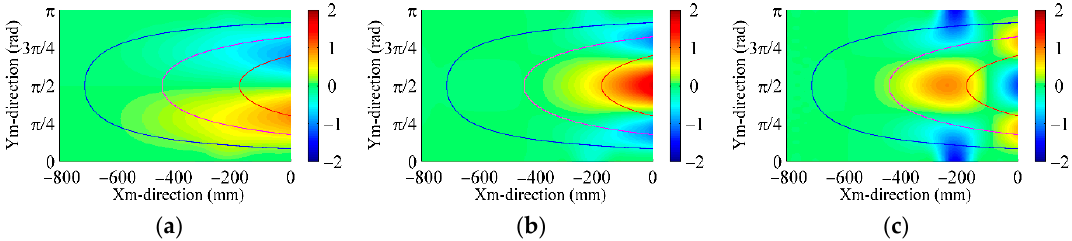
Figure 7. First three modal shapes of the semi ‐ conical shell workpiece with three chosen contour tool paths: ( a ) first modal shape; ( b ) second modal shape; ( c ) third modal shape.